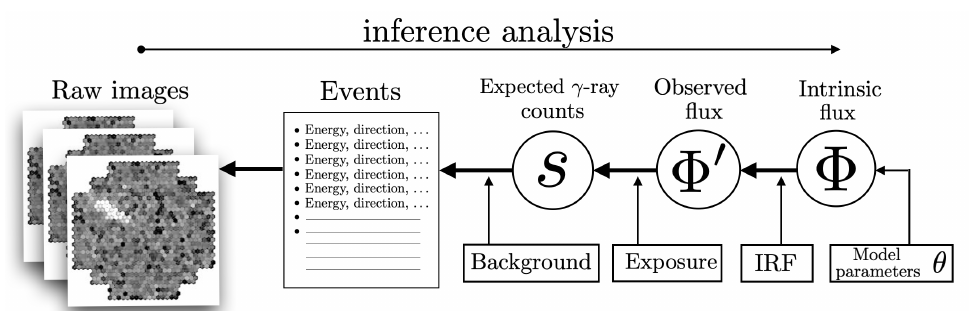
Figure 1. Schematic workflow of the inference analysis performed in order to estimate the intrinsic flux Φ of gamma rays (and the values of its parameters θ ) from the recorded images. The acronym IRF stands for Instrument Response Function (see Section 4). The bold arrows (going from the right to the left) show the relation of cause and effect. The aim of the inference analysis (shown as a thin arrow going from the left to the right) is to invert such